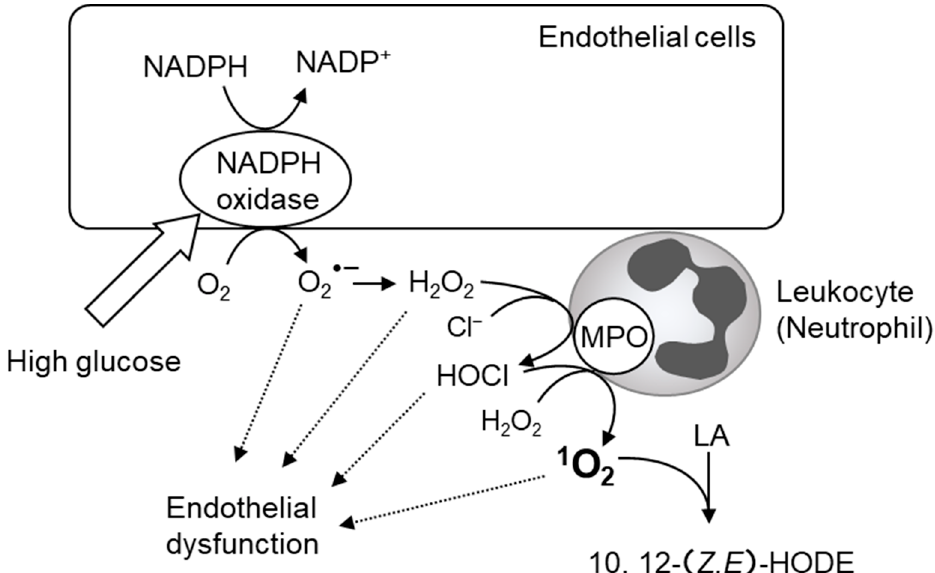
Figure 11. Assumed scheme of 1 O 2 production via NADPH oxidase and myeloperoxidase (MPO) in vascular injury in diabetes mellitus. High glucose produces hydrogen peroxide (H 2 O 2 ) by NADPH oxidase in vascular endothelial cells. 1 O 2 is generated via MPO in activated neutrophils bound to the vessel wall.